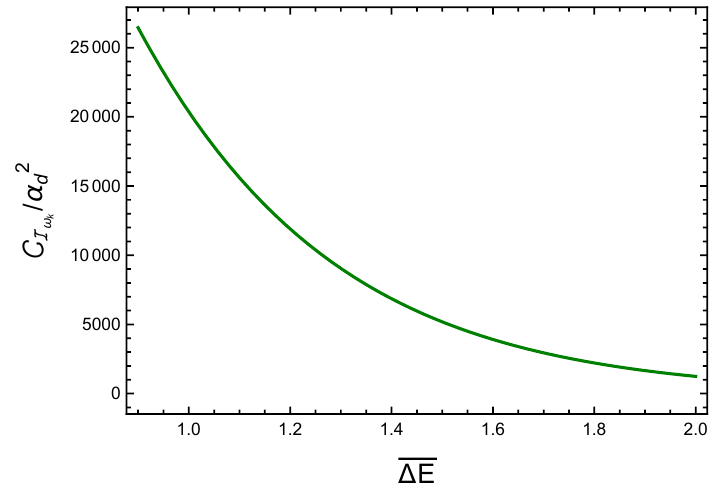
, signifying the concurrence, is plotted for two outgoing null /α 2 d ωk